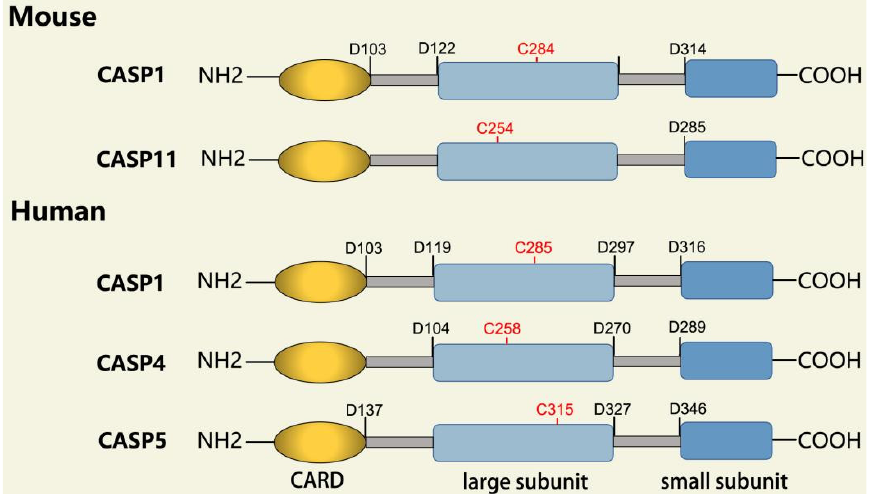
Figure 1. Domain structure of mouse (caspases-1, -11) and human (caspases-1, -4, -5) inflammatory caspases. A CDL connects N-terminal CARD to the protease domain that is composed of a large subunit (p20) and a small subunit (p10) separated by an IDL. Each caspase contains some autocleavage sites (black site) within the linker sequences. The catalytic cysteine (red site) is located within the large protease subunit, while the dimerization interface is within the small